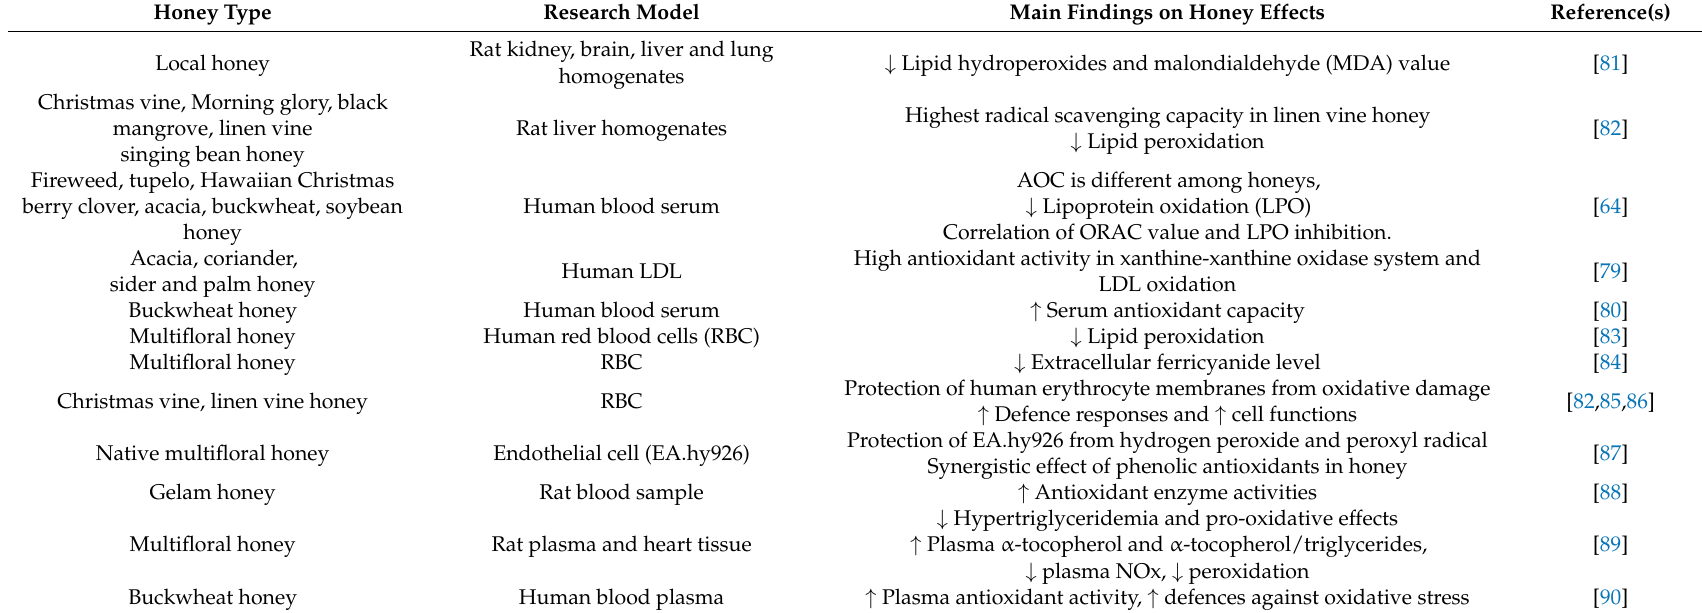
Table 3. Effects of honey on oxidative